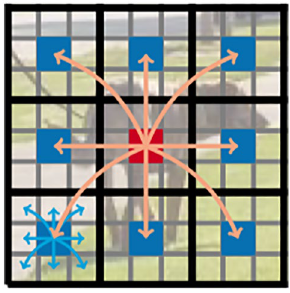
Figure 4. Each pixel sees every other pixel in our ViT block. In this example, the red pixel uses the transformer to focus on the blue pixel (the pixel in the corresponding position in the other blocks). Because the blue pixel already encodes the information of neighboring pixels using convolution, this allows the red pixel to encode the information of all pixels in the image. Here, each cell in the black and grey grid represents a block and a pixel, respectively 41 .